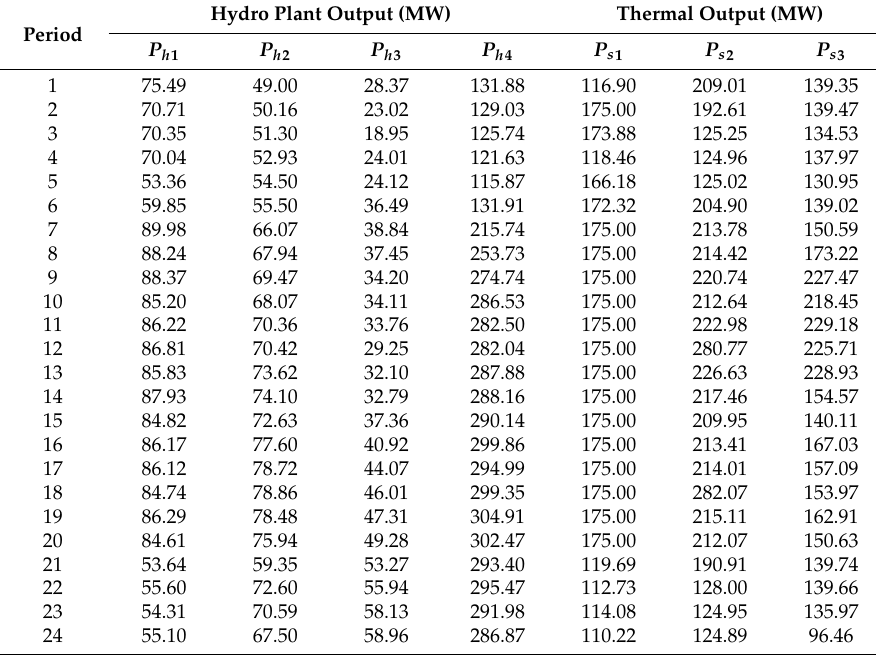
Table 4. The detailed results of scheme 15 by PMOGA for case